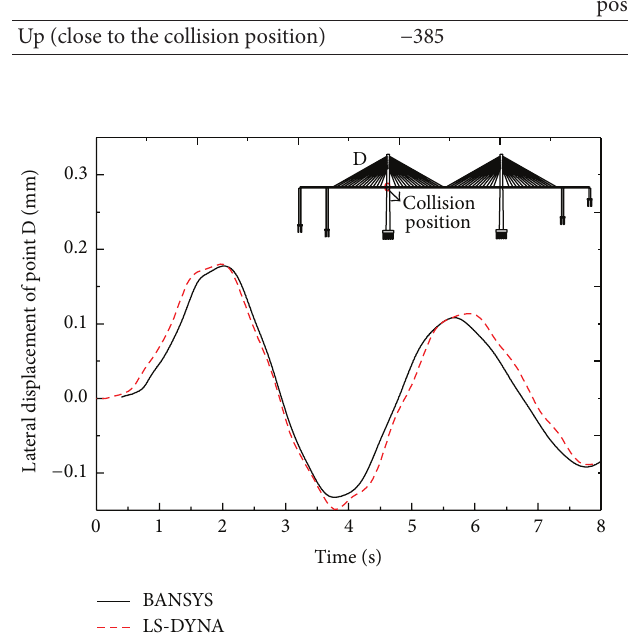
Figure 8: Lateral displacement of thegirder at the collision position.